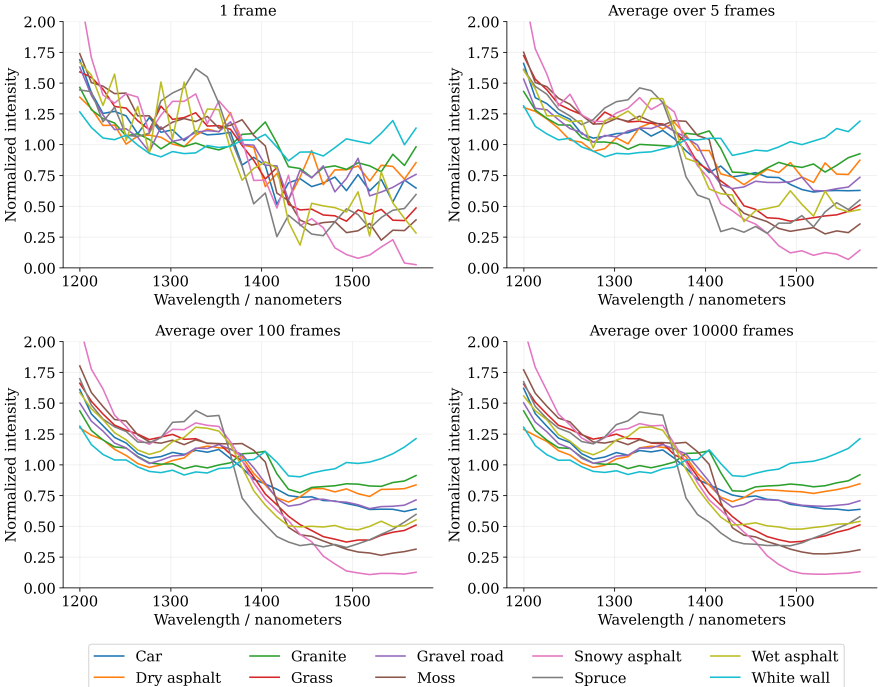
Figure 8. Visualization of the characteristic (average over all 30 samples in each class) relative reflectance spectra with respect to block size. The spectra have been computed over a block of consecutive frames with block sizes N frames ∈ { 1,5,100,10,000 } . The spectral curves are noisy due to photon shot noise in the low-photon flux regime, but the noise gradually reduces as the block-size increases.